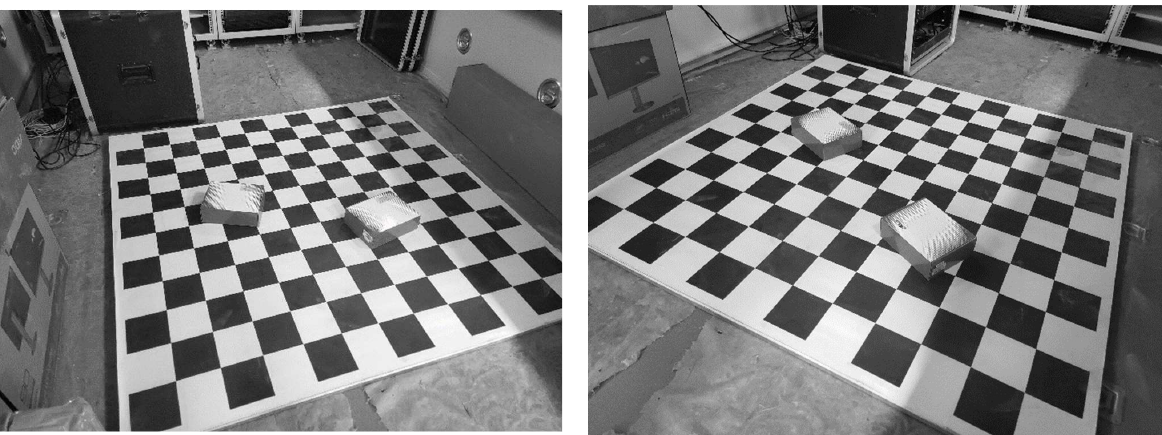
Figure 8. Real images captured from two different perspectives. Two rectangular boxes are placed on a checkerboard; the sizes of the boxes and checkerboard are known. The focal length of the camera is 4.71 mm, the resolution is 4000 × 3000, and the pixel size is 1.6μm. The positions of the two cameras are given by the total station. Then, two lines are randomly chosen to estimate the pose for our proposed method, three lines for the P3L method, three points for the P3P method, four points for the GPnPf method, five points for the RPnP method and six points for the DLT method. After pose estimation using the six methods, the positions of the remaining points can be given as measured values by stereo vision [50]. Here, the measured values are denoted as